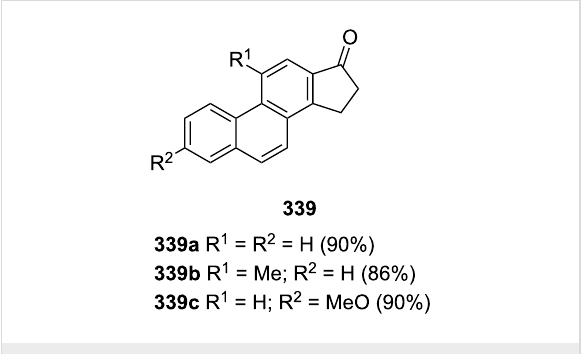
1-Indanol tricarbonylchromiums have been oxidized with MnO 2 to optically pure 1-indanone tricarbonylchromium derivatives by Jaouen and Meyer